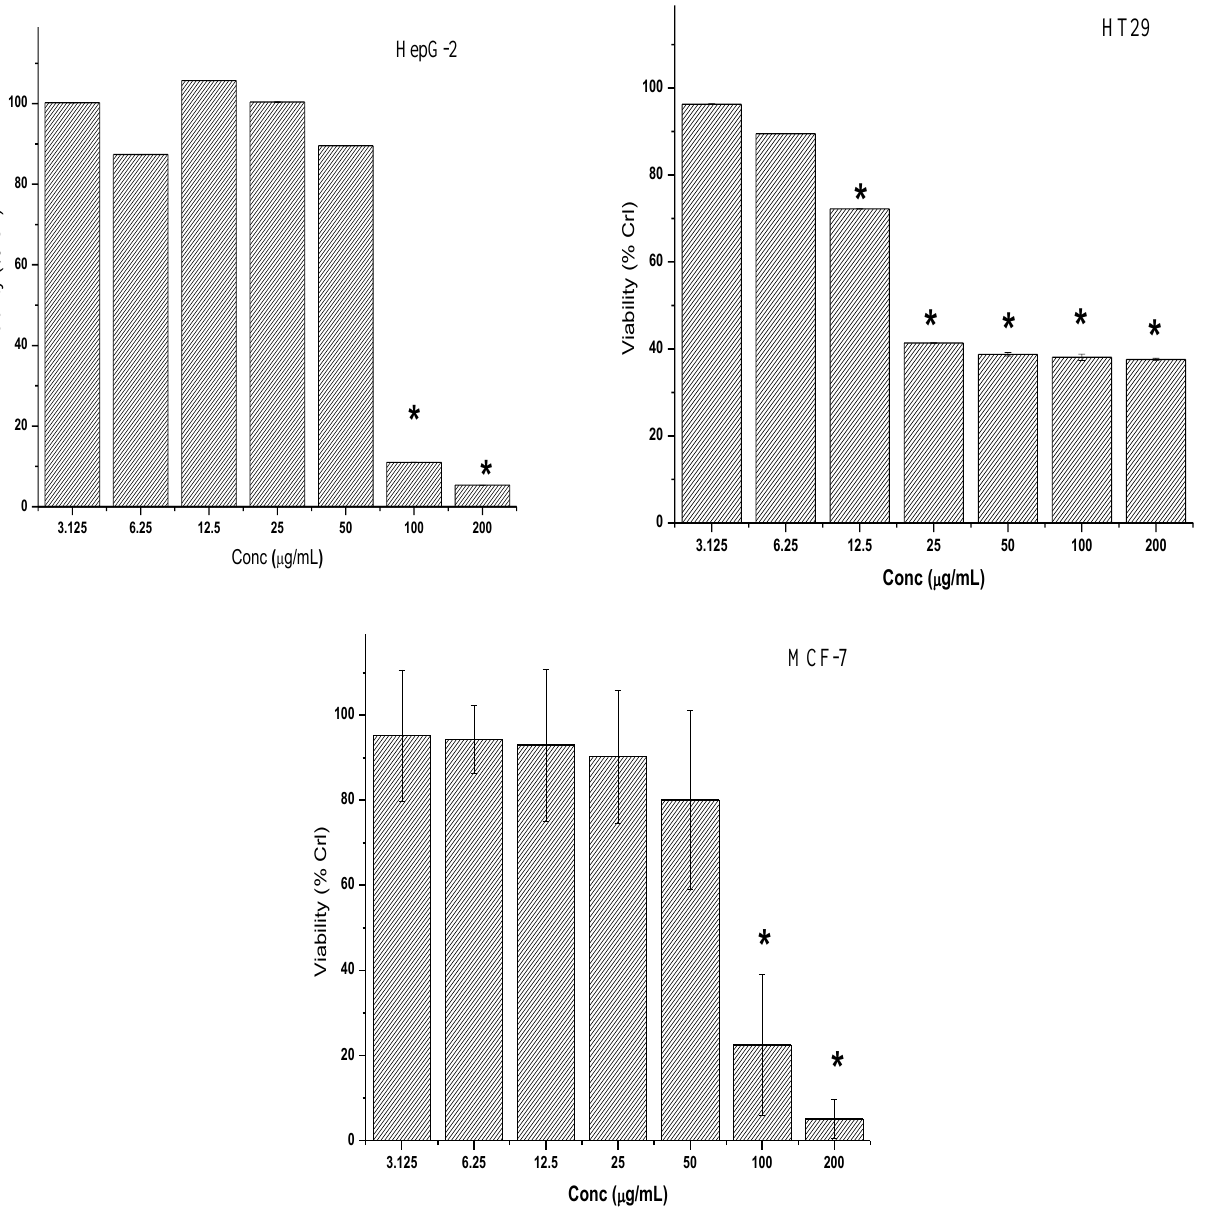
Figure 5. Cytotoxic effect of the petroleum ether extract on HepG2, HT-29 and MCF-7 cancer cell lines. Cells were exposed to increasing concentrations of the crude extracts for 72 h. The results of the three independent tests are shown as the mean ± SD. * Asterisk indicates significant difference at p < 0.005.